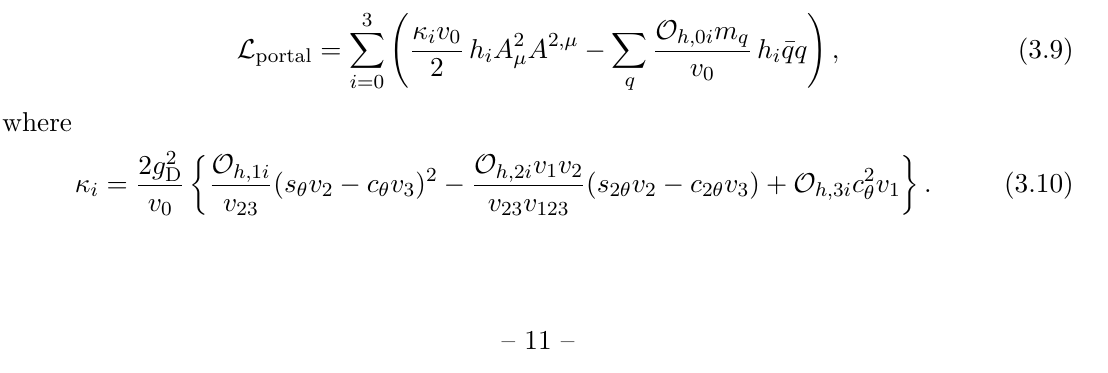
Figure 3. Effective annihilation cross sections h σ ann v i as functions of x = m mark points. The freeze-out point for each curve is indicated by a star